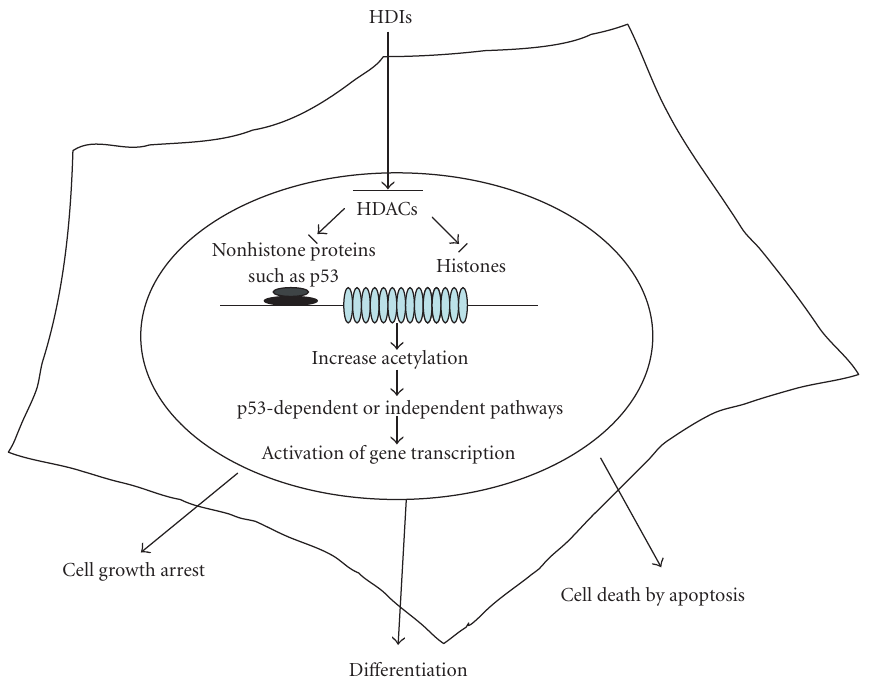
Figure 3: A schematic model for HDIs mode of action. Complex molecular interactions involve acetylation and deacetylation events of histone in the vicinity of promoters and of nonhistone proteins, such as transcription factor p53. Acetylation and deacetylation a ff ect cell cycle transition through regulation of proteins such as p21 WAF1 and cyclin B1. The pathways could be dependent on or independent of